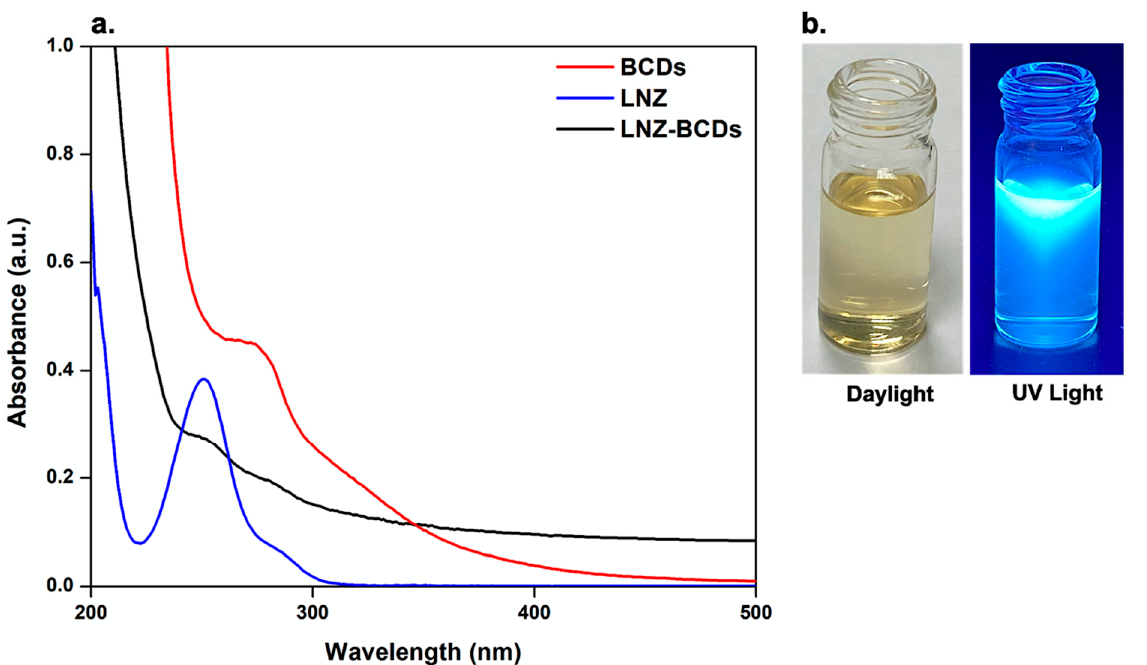
Figure 5. ( a ) UV-visible absorption spectra of pure LNZ, BCDs nano-biocarrier, and LNZ–BCDs nano-bioconjugate, and ( b ) photographic images of BCDs nano-biocarrier in daylight and under UV light excitation at 365